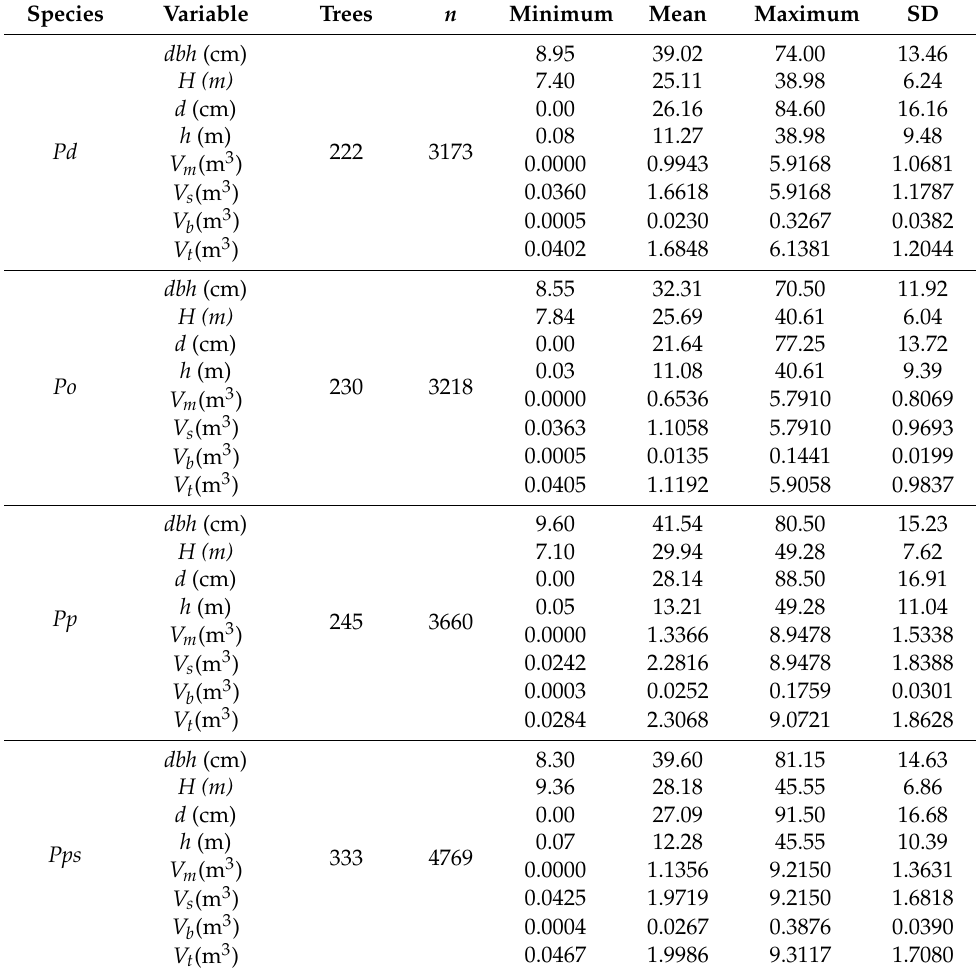
Table 1. Descriptive statistics of the studied pine tree